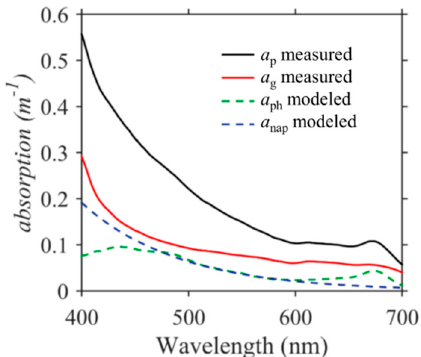
Figure 3. Example station showing the measured spectral particulate and dissolved absorption coe ffi cients ( a p and a g ) and the modeled results from partitioning a p into absorption by phytoplankton ( a ph ) and non-algal particles ( a nap ).